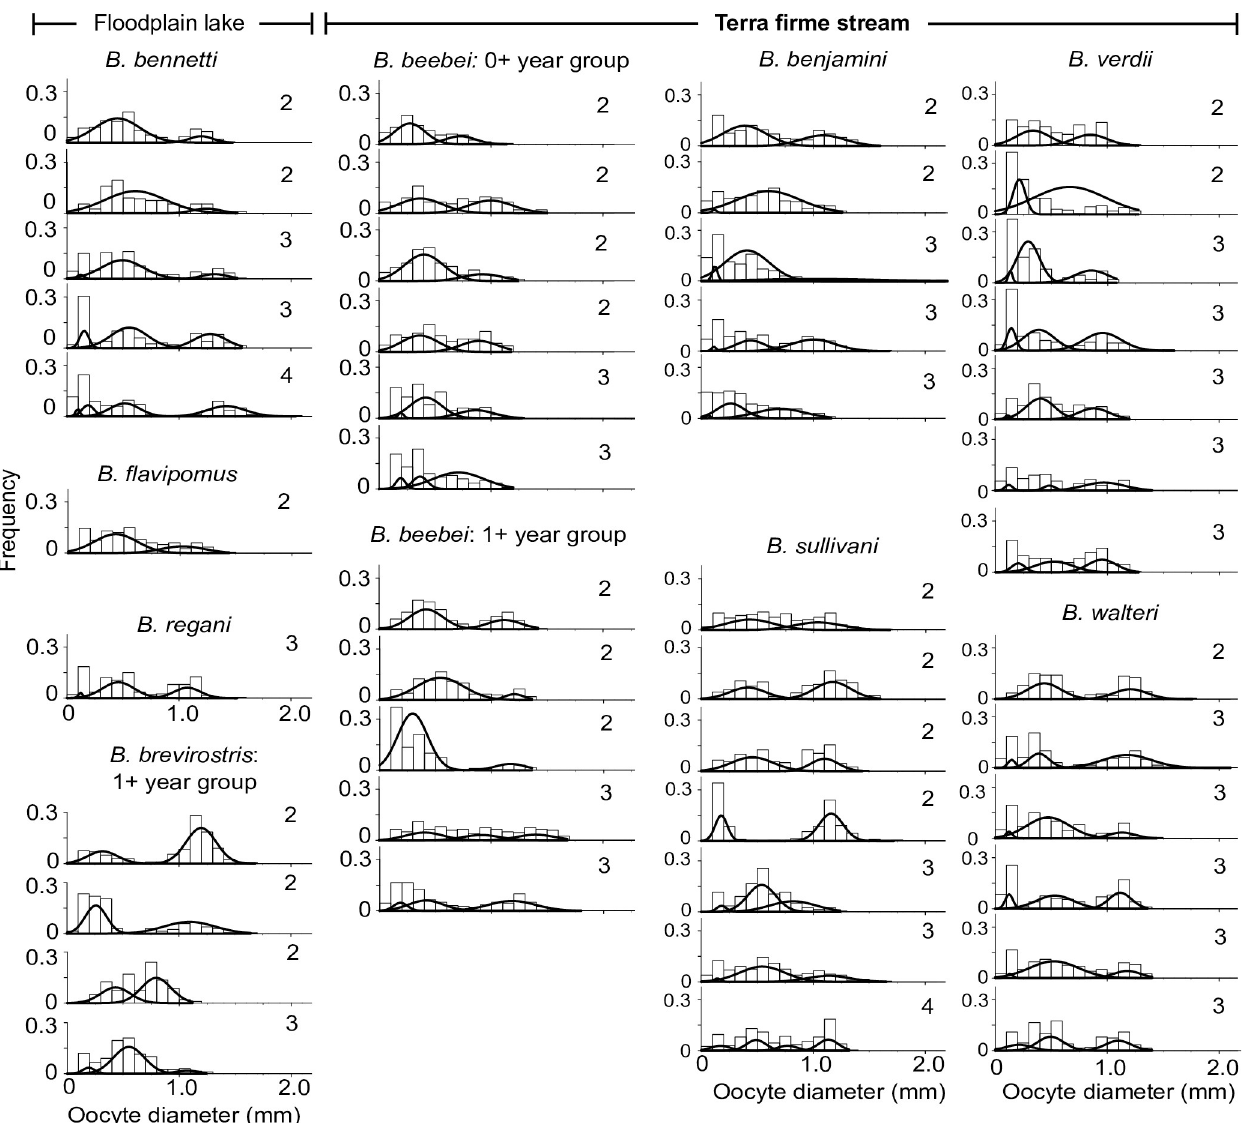
Fig 10. Histograms of oocyte diameters in spawning capable females of nine species of Brachyhypopomus in the active spawning subphase (Stage 4). Dashed curves represent Gaussian distributions fitted by Finite Mixture Models to show modal size groups. The number of size modes is reported to the right of each